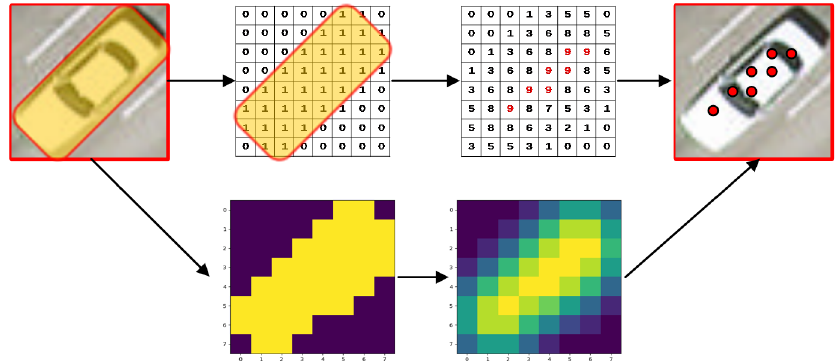
Figure 8. Example of accurate foveal area sampling.